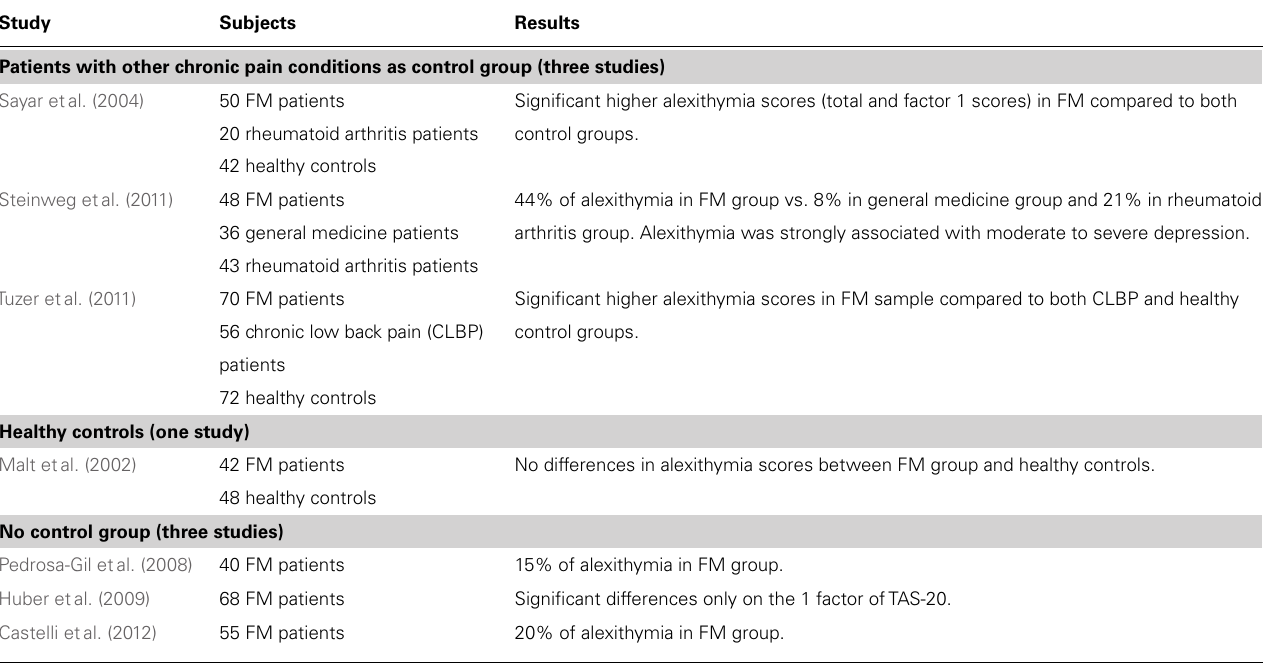
Table 1 | Examined studies concerning the multivariate relationship between FM syndrome and alexithymia (TAS-20). Study Subjects Results Patients with other chronic pain conditions as control group (three studies) Sayar etal. (2004) Significant higher alexithymia scores (total and factor 1 scores) in FM compared to both control groups.